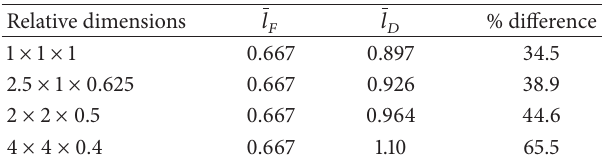
Figure 3: 𝑓(𝑙) and 𝑑(𝑙) distributions for a rectangular parallelepiped with relative dimensions 2 × 2 × 0.5 . Table 1: 𝑙 𝐹 and 𝑙 𝐷 values for a selection of rectangular paral- lelepipeds of varying relative